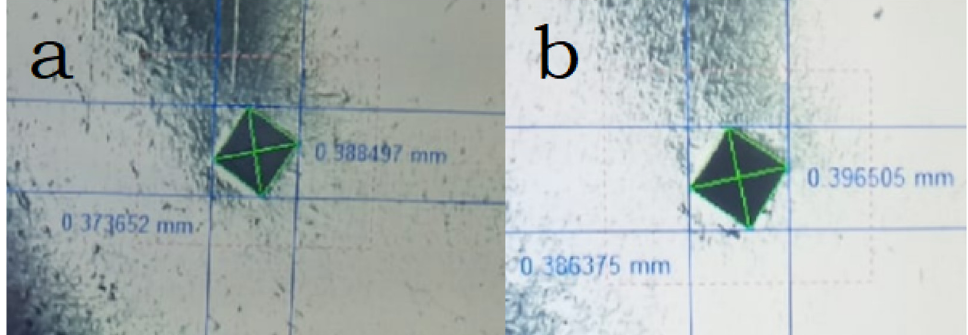
Figure 7. Imprint of the hardness tester indenter of samples sintered at different temperatures: ( a ) 900 °C, ( b ) 800 °C.